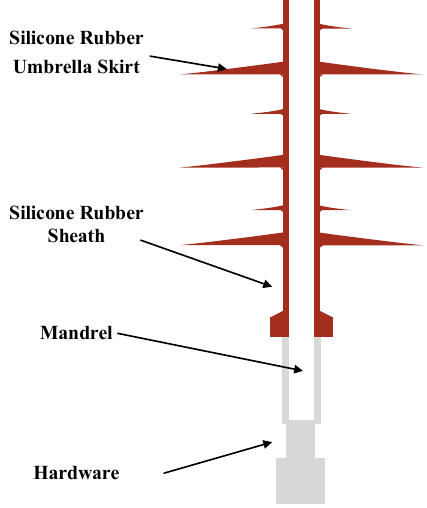
Figure 1. Composite insulator structure diagram.